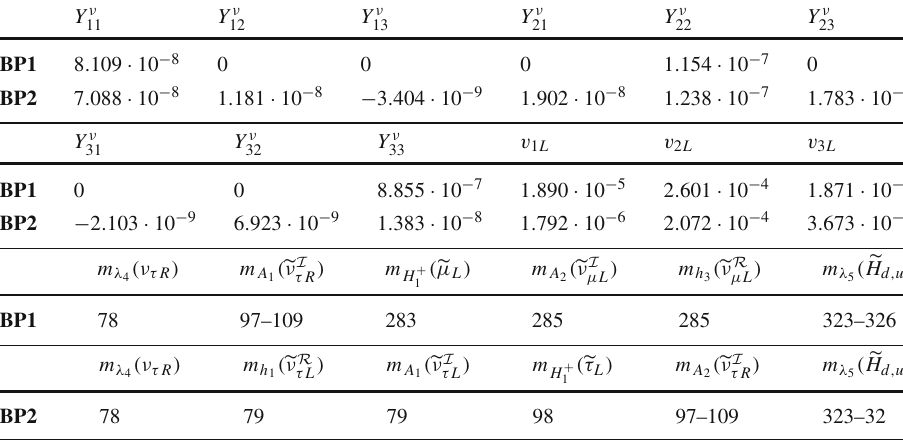
and BP2 used to fit the neutrino oscillation data accurately in the scan reproducing the LEP and the CMS excesses. In the last four rows we list the masses of the six lightest non-SM